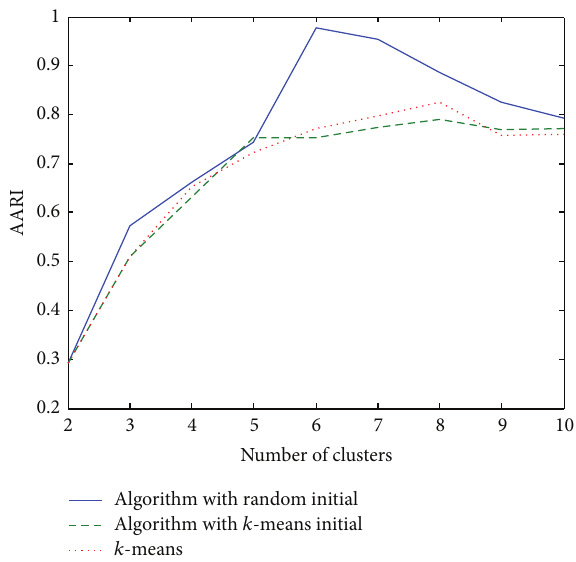
Figure 4: Plot of AARI with different numbers of